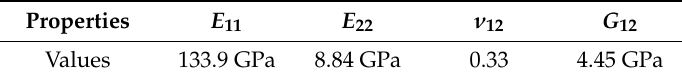
Table 2. Elastic properties of shell element in FE model [1].